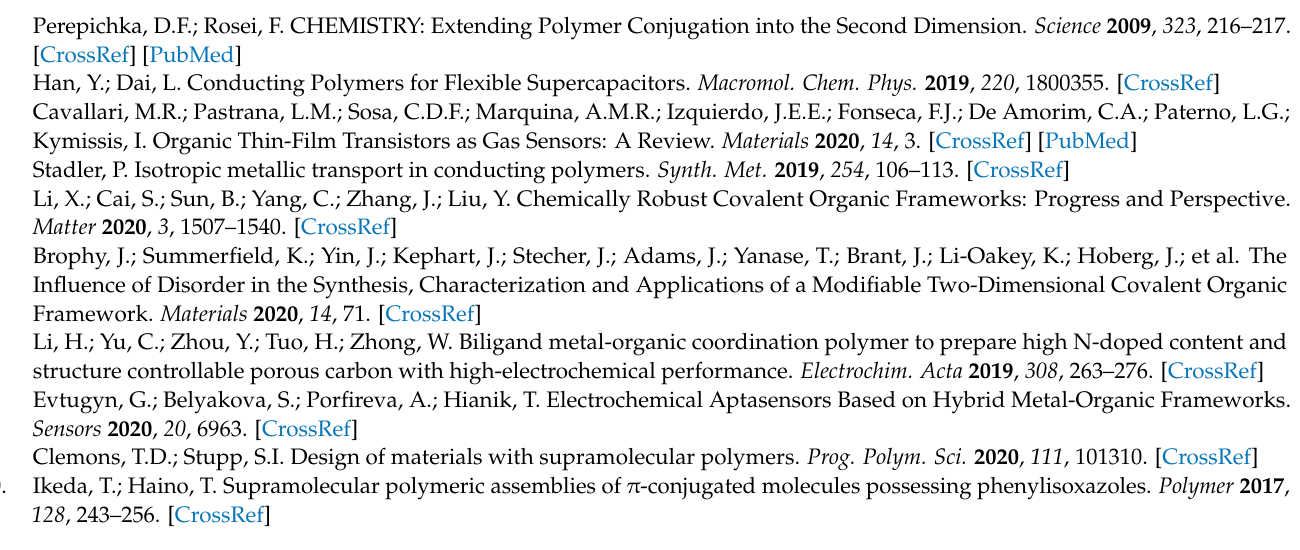
and 0.1 M Bu4NBF4/DMSO; product under polarization in monomer-free 0.1 M Bu4NBF4/DMSO (insert); 50 mV/s. Figure S3: Simulated UV-Vis-NIR spectra of 1 states, calculated at TDDFT/CAM- B3LYP/6-31G(d)/CPCM(DCM). Figure S4: UV-Vis-NIR spectrum for neutral monomer 1 ( black ); neutral p(1)-II under − 0.5 V polarization ( green ); p(1)-II oxidized at 1V ( red ) in 0.1 M Bu 4 NBF 4 /DCM solution. Figure S5: Change in absorbance of UV-Vis under polarization of p(3) in the range of polaron ( red ) and bipolaron forming ( blue ) in 0.1 M Bu 4 NBF 4 /DCM solution. Table S1: Cartesian coordinates of the optimized structures of perimidine-carbazole monomers, calculated at B3LYP hybrid functional combined with 6-31G(d) basis set. Table S2: Shape of frontier orbitals of monomers calculated at B3LYP/6-31G(d)/CPCM(DCM). The isovalue is equal to 0.03 e − /au 3 in each case. Table S3: Spin density of oxidized and reduced form monomers calculated at B3LYP/6-31G(d)/CPCM(DCM), isovalue is equal to 0.005 e − /au 3 . Table S4: Shape of frontier orbitals of selected dimers calculated at B3LYP/6-31G(d)/CPCM(DCM). The isovalue is equal to 0.03 e − /au 3 in each case. Table S5: Summary of electrochemical parameters of monomers in 0.1 M Bu 4 NBF 4 / DCM, potentials vs Fc|Fc + . Table S6: Optimized structures of 1 π -dimers of radical cations (left) and di(radical cations) (right), calculated at (cid:36) B97X-D functional combined with 6-31G(d,p) basis